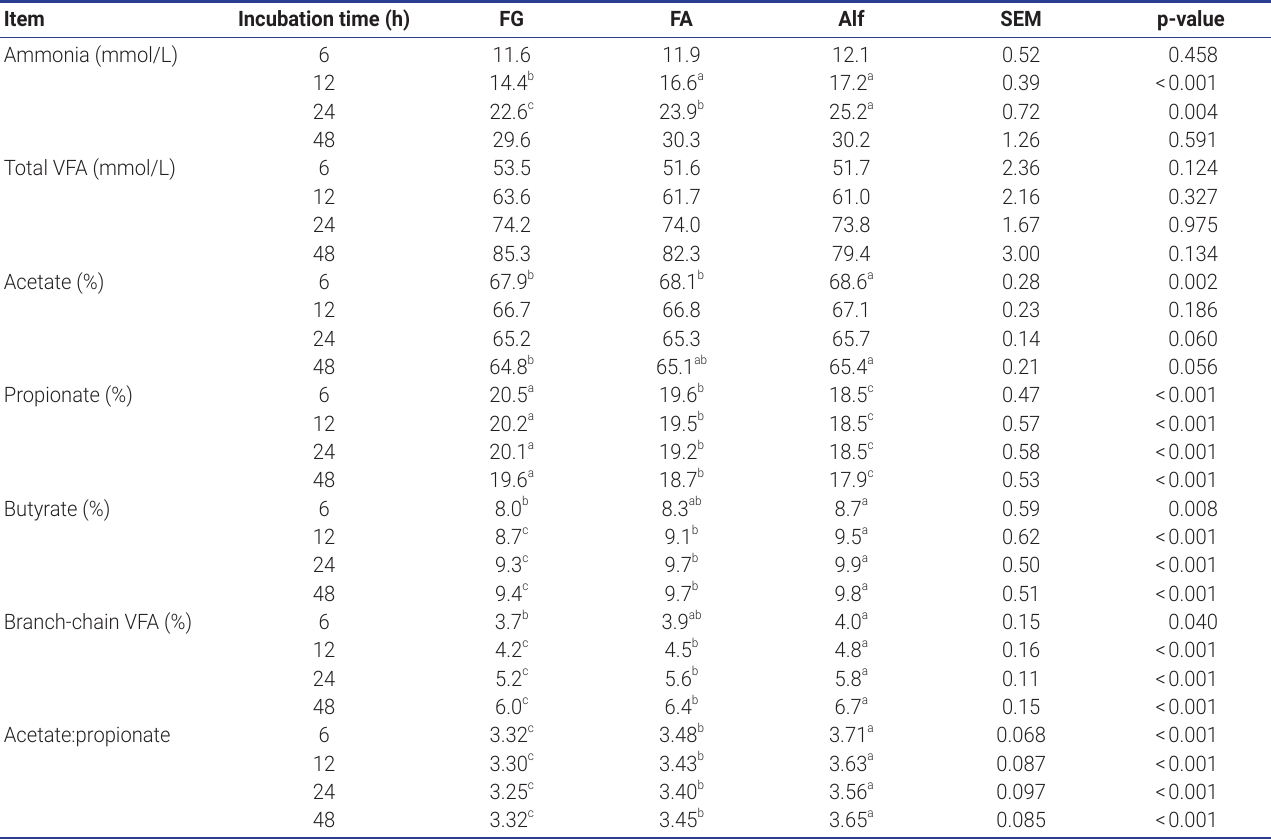
Table 6. Ammonia concentration and profile of volatile fatty acids (VFA) in liquid fraction of whole culture of in vitro ruminal incubation of mature forages Item Incubation time (h)